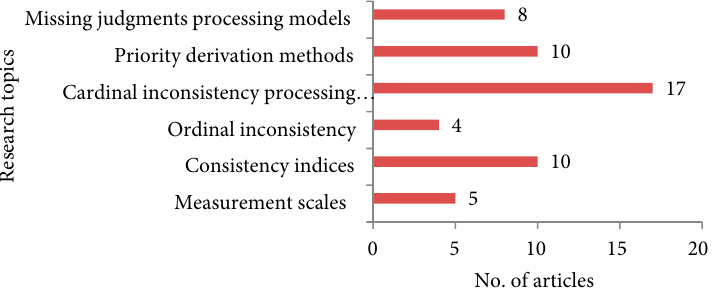
Fig. 2. The distribution of researches on the main developments of multiplicative and additive